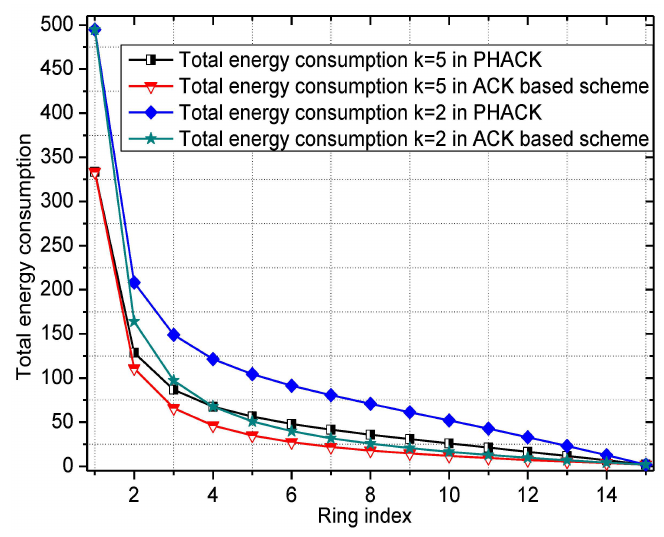
Figure 5. The total energy consumption in different